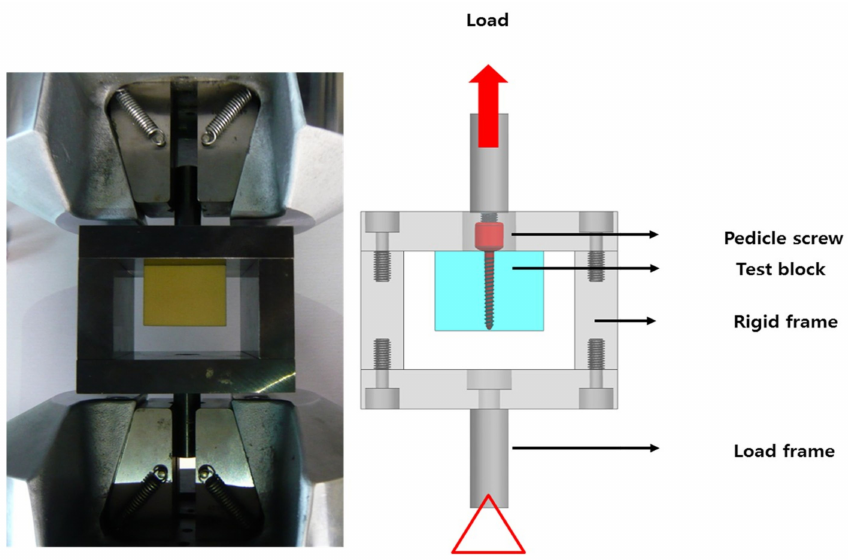
Figure 4. Experimental configuration used for testing the axial pullout strength of pedicle screws.